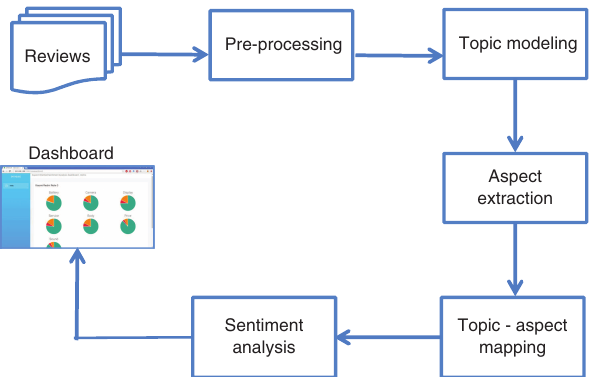
Figure 1: Overall Workflow of the Proposed Approach for Topic Modeling-Guided Aspect-Oriented Sentiment Analysis. Table 1: Topics Extracted by LDA Algorithm (Because of Space Constraints, We Show Only the First Five Topics Generated).